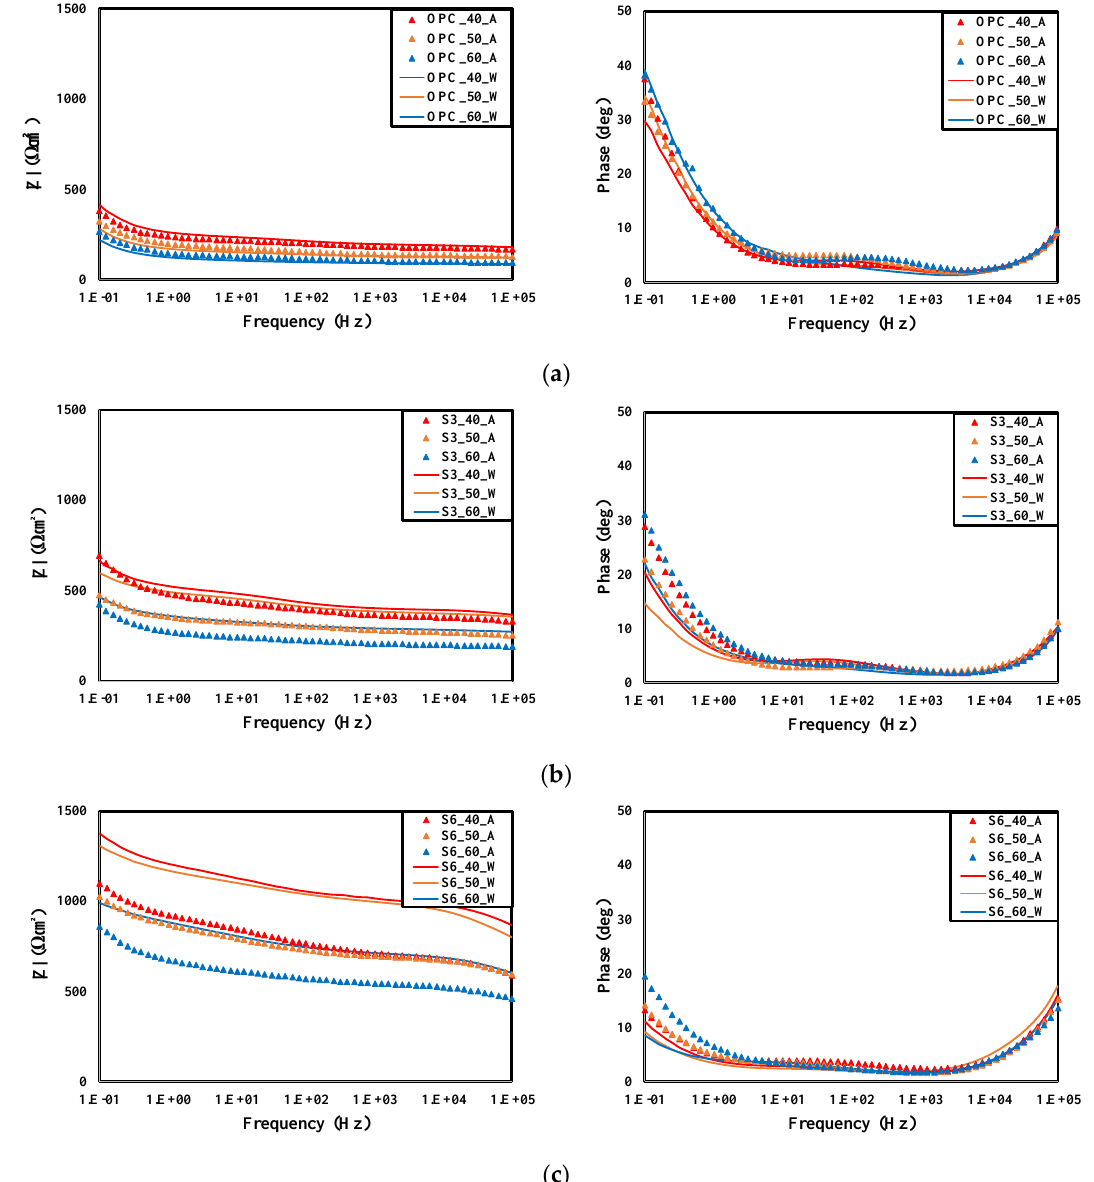
Figure 9. Bode modulus plot and phase plot of rebars embedded in concrete according to the curing condition. ( a ) OPC, ( b ) OPC 70% + GGBFS 30%, ( c ) OPC 40% + GGBFS 60%.